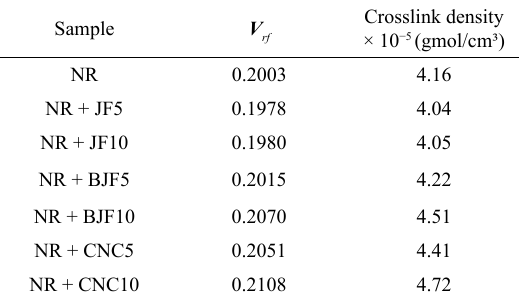
Table 6. Volume fraction of the rubber phase in the swollen gel of the rubber vulcanizate (V ) and crosslinking density of the NR rf and NR